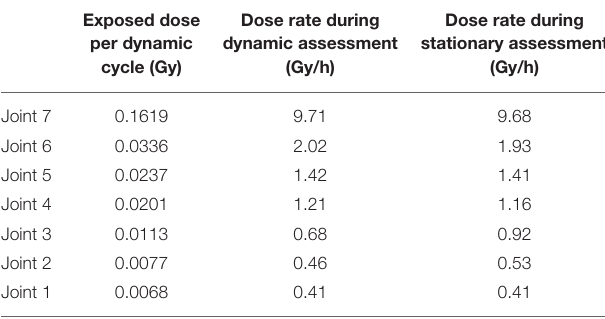
TABLE 2 | The air kerma exposure dose at each robot joint, measured using the diamond dose rate system. During dynamic During stationary Overall exposed dose assessment (Gy) assessment (Gy) before failure